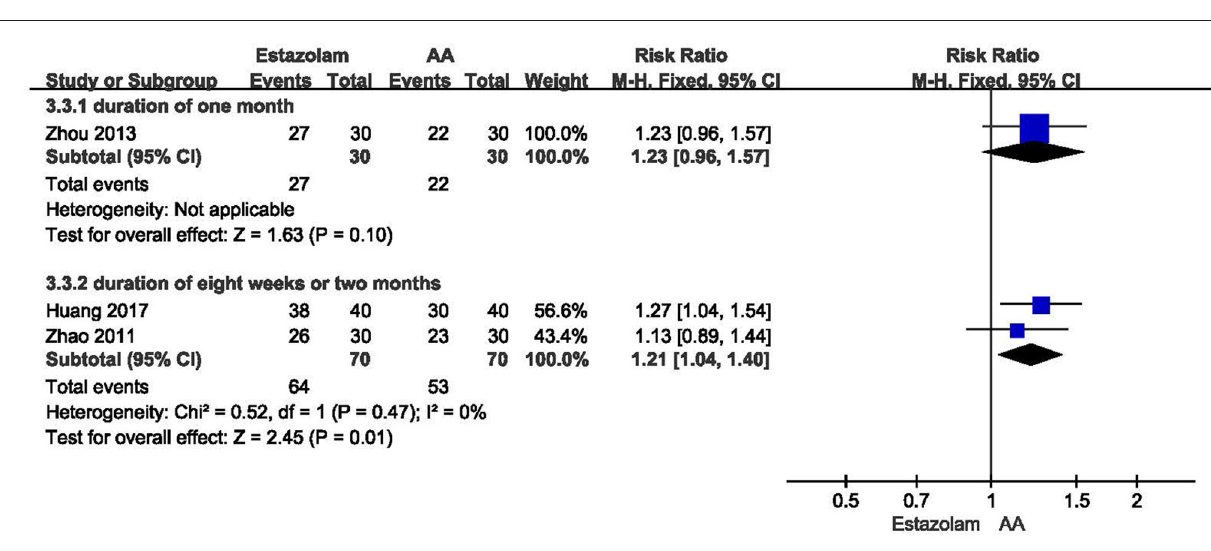
FIGURE 5 | Meta-analysis of AA vs. estazolam on response